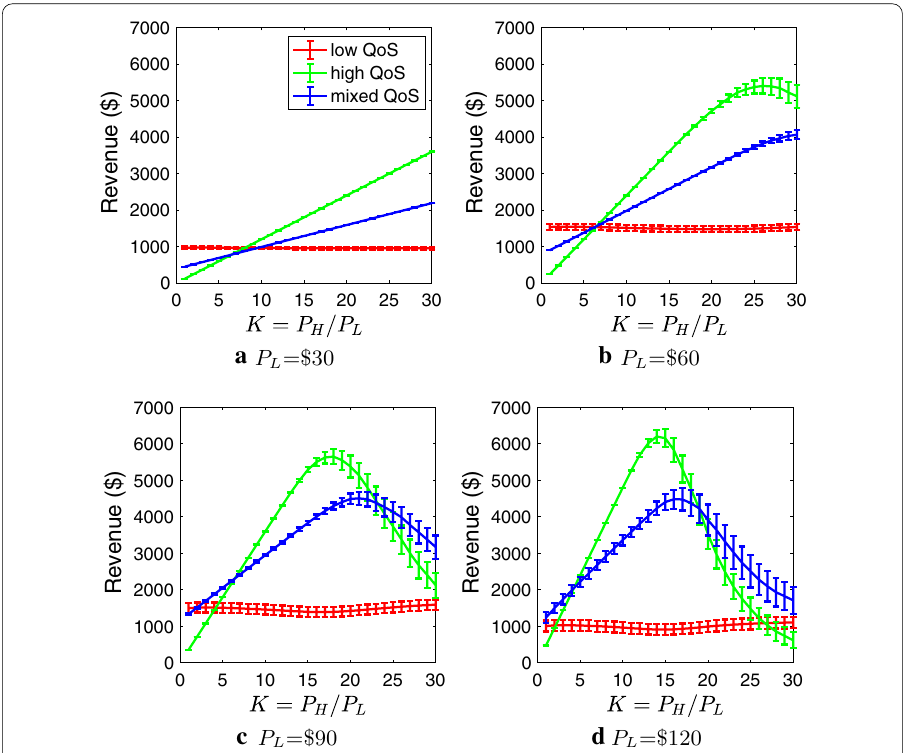
Fig. 1 Evolution of the revenue for the three QoS scenarios. Technical parameters: carrier frequency f 3800 MHz and indoor propagation environment. Parameters of the distribution of the budgets B L and B H : = µ L = 0.7 P L ,max , σ L = 0.4 P L ,max , µ H = 0.4 Q H Q